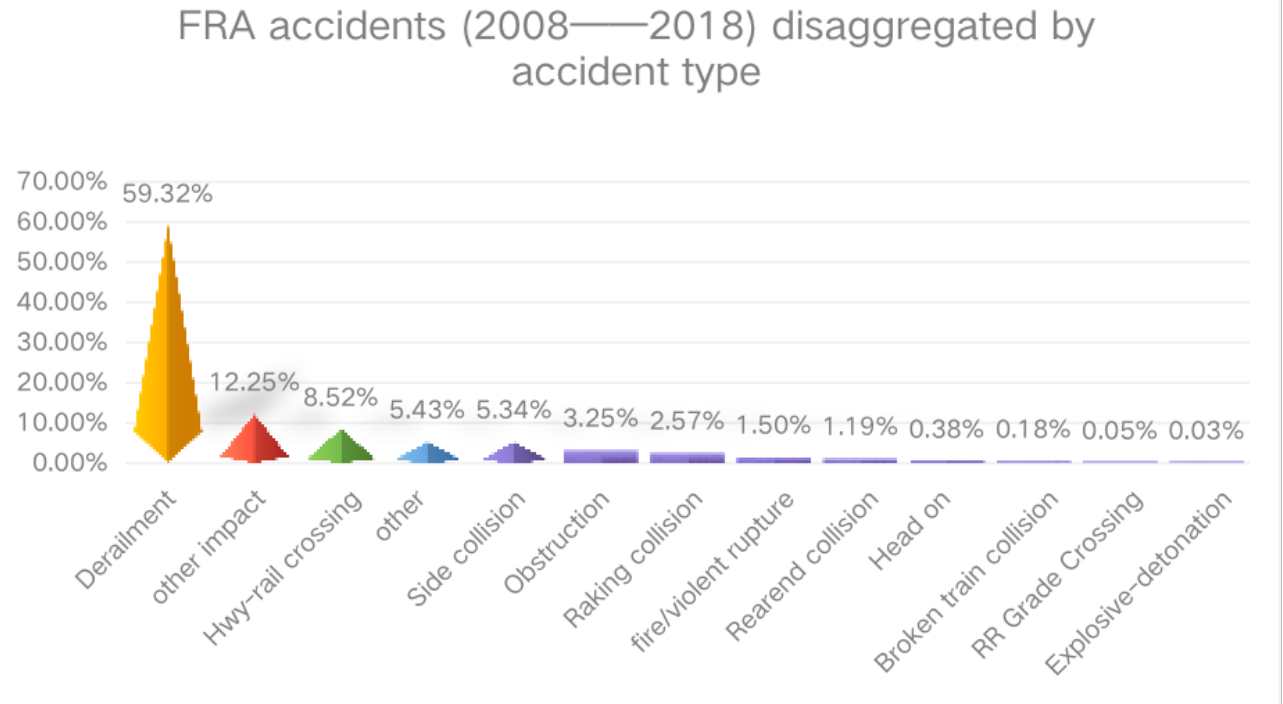
Figure 3. Federal Railroad Administration (FRA) accidents disaggregated by accident